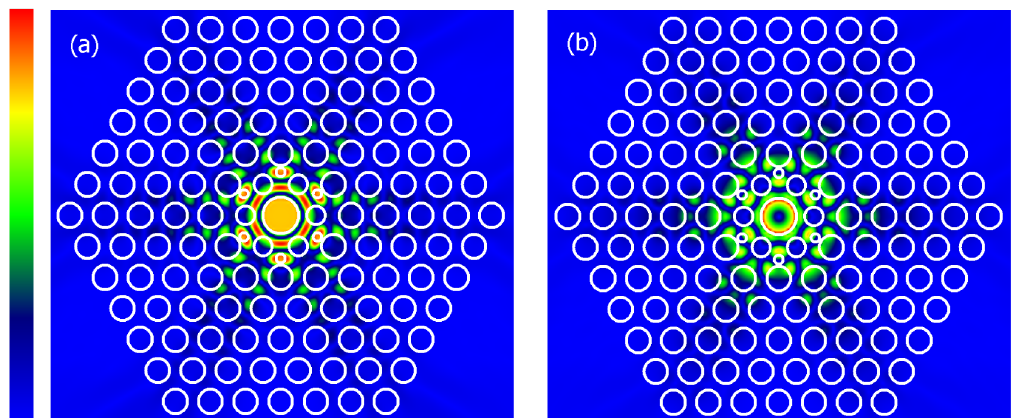
FIG. 15. (a) Longitudinal and (b) radial electric field of the TM mode calculated with the multipole method for a Lin-type fiber with extra microholes in the defect region.